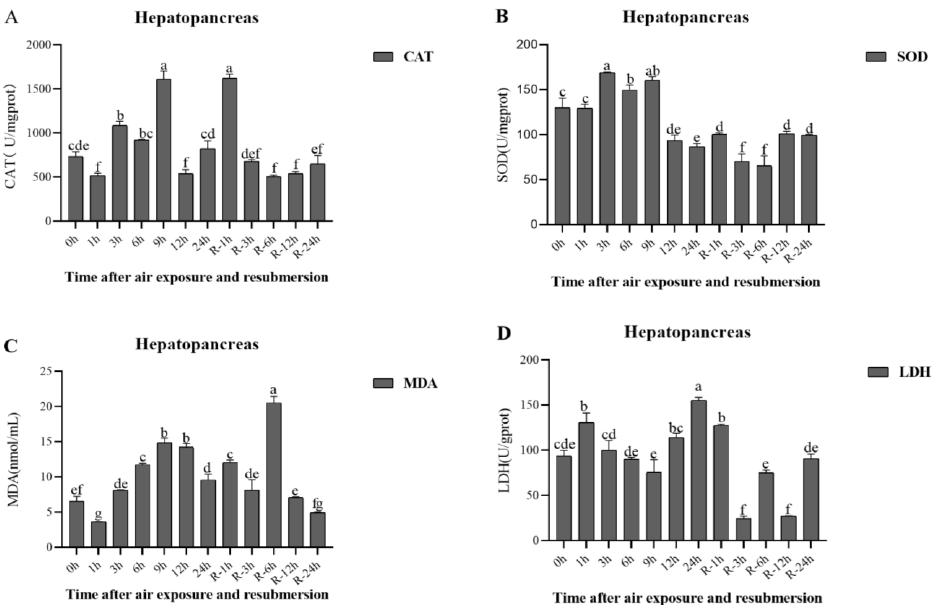
Figure 3. CAT activity ( A ), SOD activity ( B ), MDA content ( C ), and LDH activity ( D ) in the hepatopancreas of P. clarkii after air exposure for 0 h, 1 h, 3 h, 6 h, 9 h, 12 h and 24 h, including re-submersion for R-1 h, R-3 h, R-6 h, R-12 h, R-24 h. Different letters show significant differences between different exposure times in the same tissue ( p < 0.05).